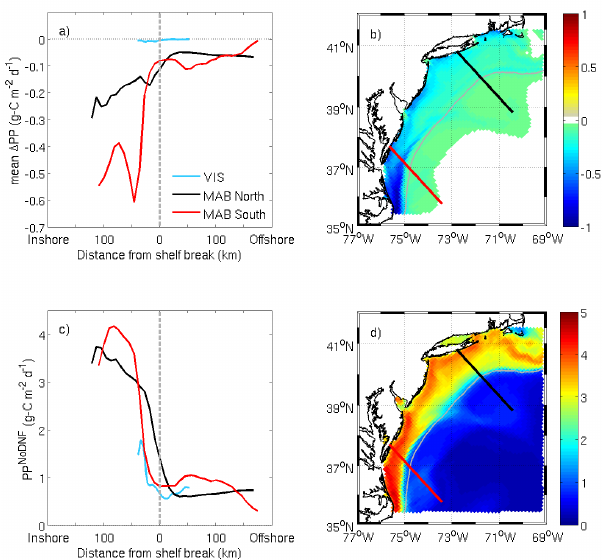
Fig. 3. (a, b) Change (in %) of oxygen concentrations in the near- bottom layer of the two models due to the presence of sediment Fig. 4. (a, b) Change (in gCm − 2 d − 1 ) of vertically integrated (cid:16) (cid:17) − O NoDNF / O NoDNF denitrification ( 1 O 2 =100 % × O DNF ), av- primary production due to the presence of sediment denitrifica- 2 2 2 tion ( 1 PP = PP DNF − PP NoDNF ), averaged in the 75-day period eraged in the 75-day period of study: (a) Mean 1 O 2 as a function of study. (a) Mean 1 PP as a function of distance from the shelf of distance from the shelf break in the VIS quasi-2-D model and break in the VIS quasi-2-D model and in two transects from the in two transects from the MAB model; (b) Map of mean 1 O 2 for MAB model. (b) Map of mean 1 PP for MAB domain, showing MAB domain, showing the two transects used in (a) . (c, d) Aver- the two transects used in (a) . (c, d) Averaged vertically integrated aged oxygen concentrations (mmolm − 3 ) in the near-bottom layer primary production (gCm − 2 d − 1 ) in the two models for the exper- of the two models for the experiments without sediment denitrifica- iments without sediment denitrification (PP NoDNF ): (c) same as (a) ; (d) same as (b) ): (c) same as (a) for mean O NoDNF tion (O NoDNF 2 2 for mean PP NoDNF ; (d) same as (b) for PP NoDNF . The dashed verti- for O NoDNF . The dashed vertical lines in (a) and (c) indicate the po- 2 cal lines in (a) and (c) indicate the position of the shelf break (200m sition of the shelf break (200m isobath), shown as a grey contours isobath), shown as a grey contours in (b) and (d) in (b) and (d) .